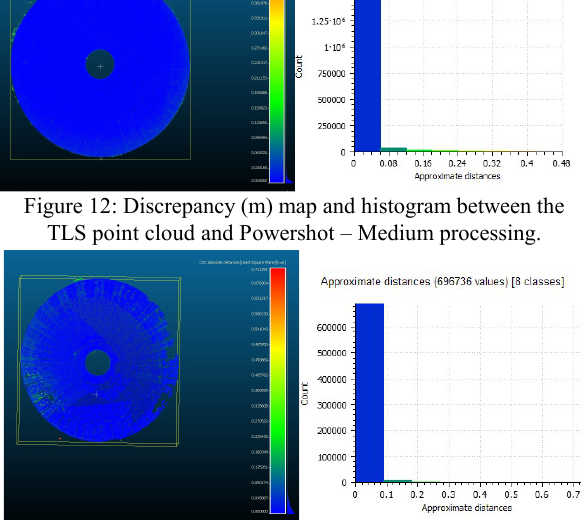
Figure 12: Discrepancy (m) map and histogram between the TLS point cloud and VisualSfM processing.